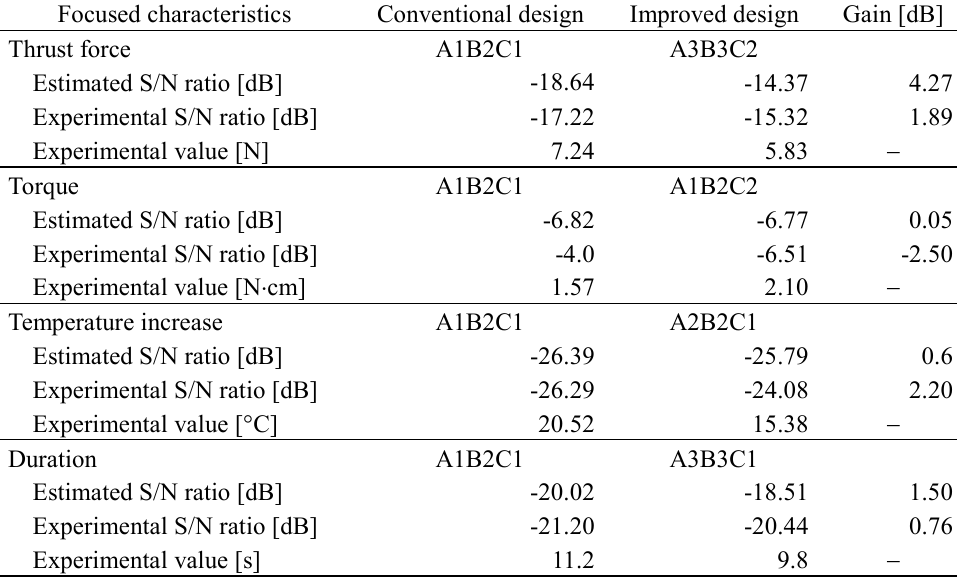
Table 5 Results for drill design confirmation